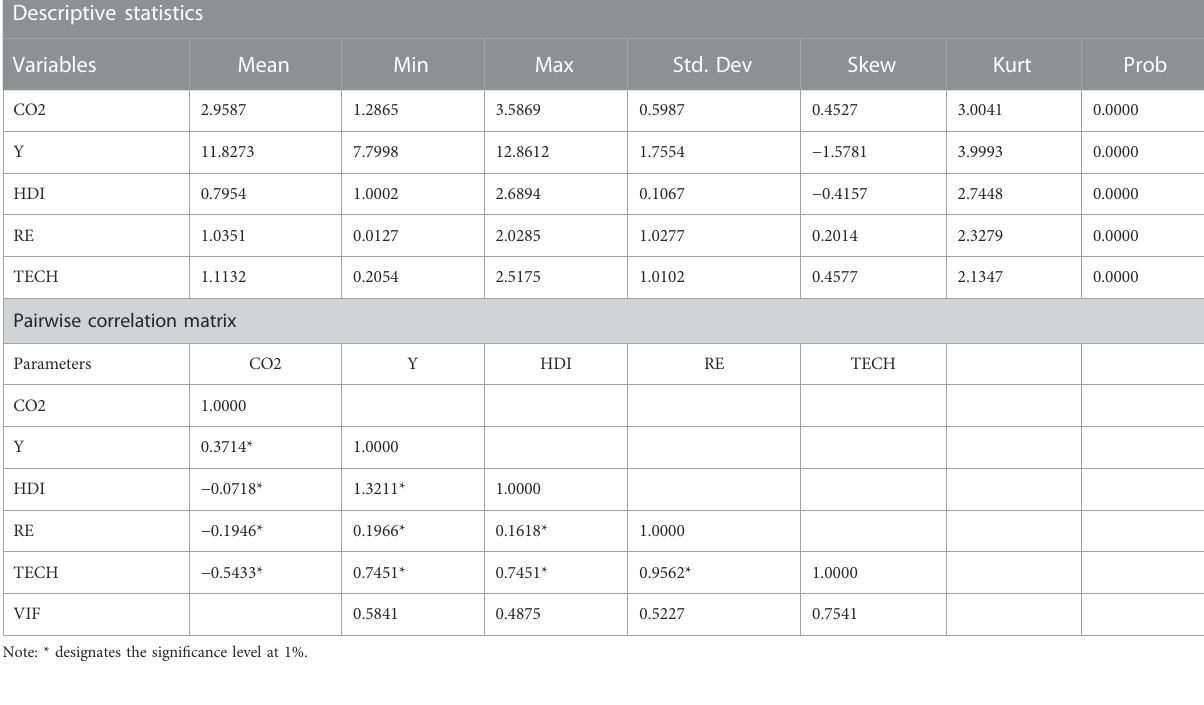
TABLE 2 Descriptive statistics and pairwise correlation matrix.